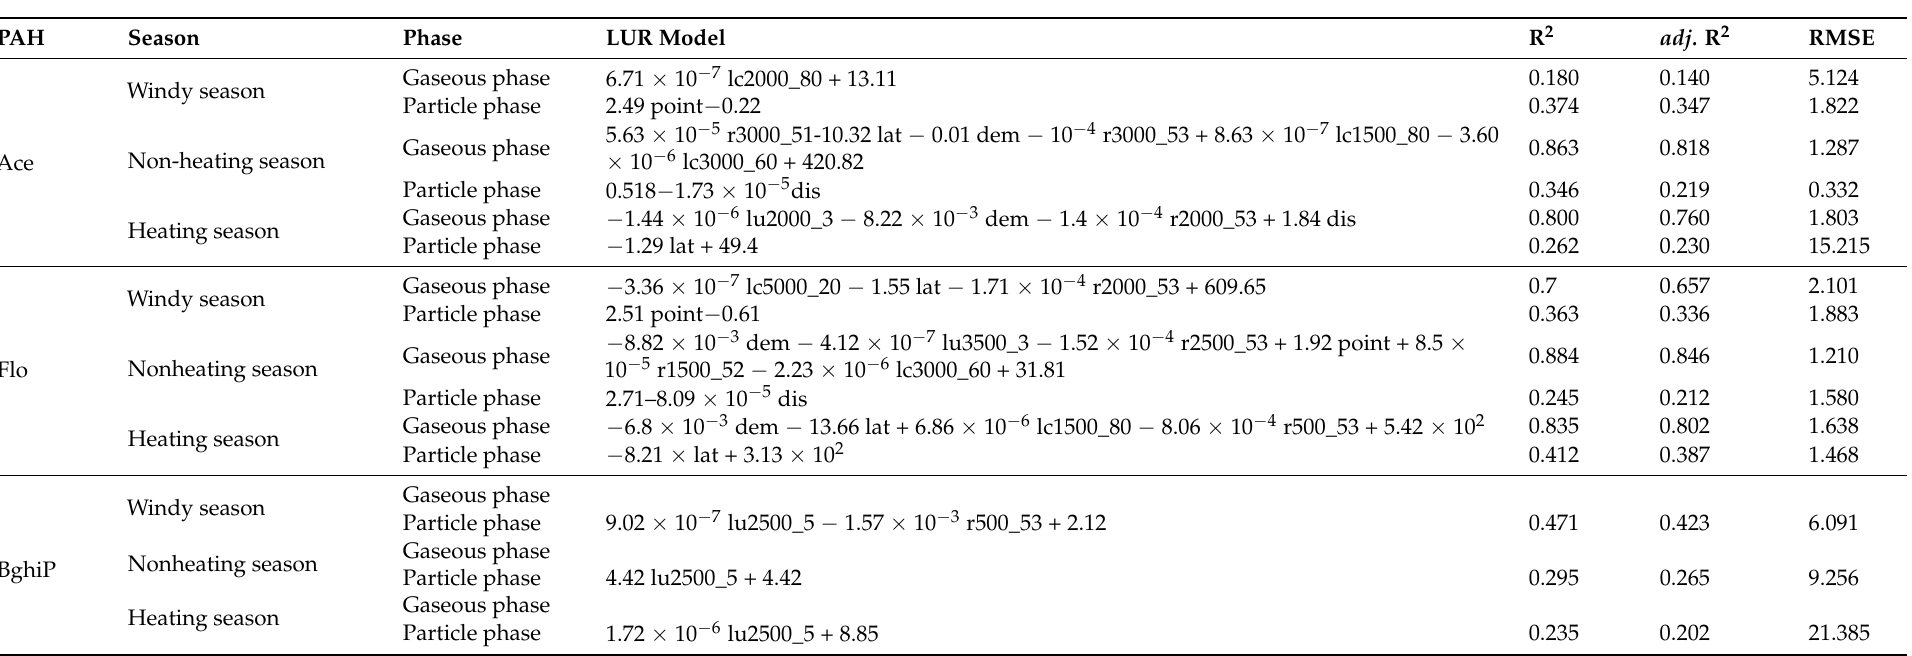
Table 2. LUR models for Ace, Flo, and BghiP in